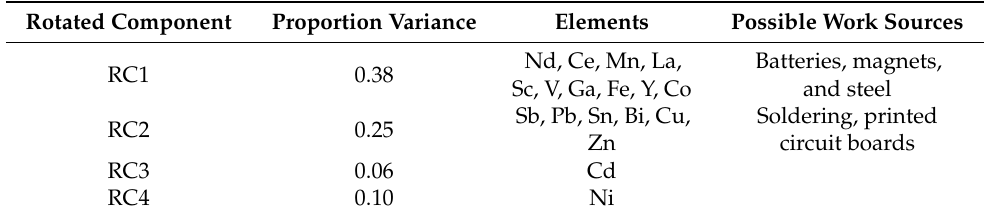
Table 2. Rank principal component analysis with varimax rotation.